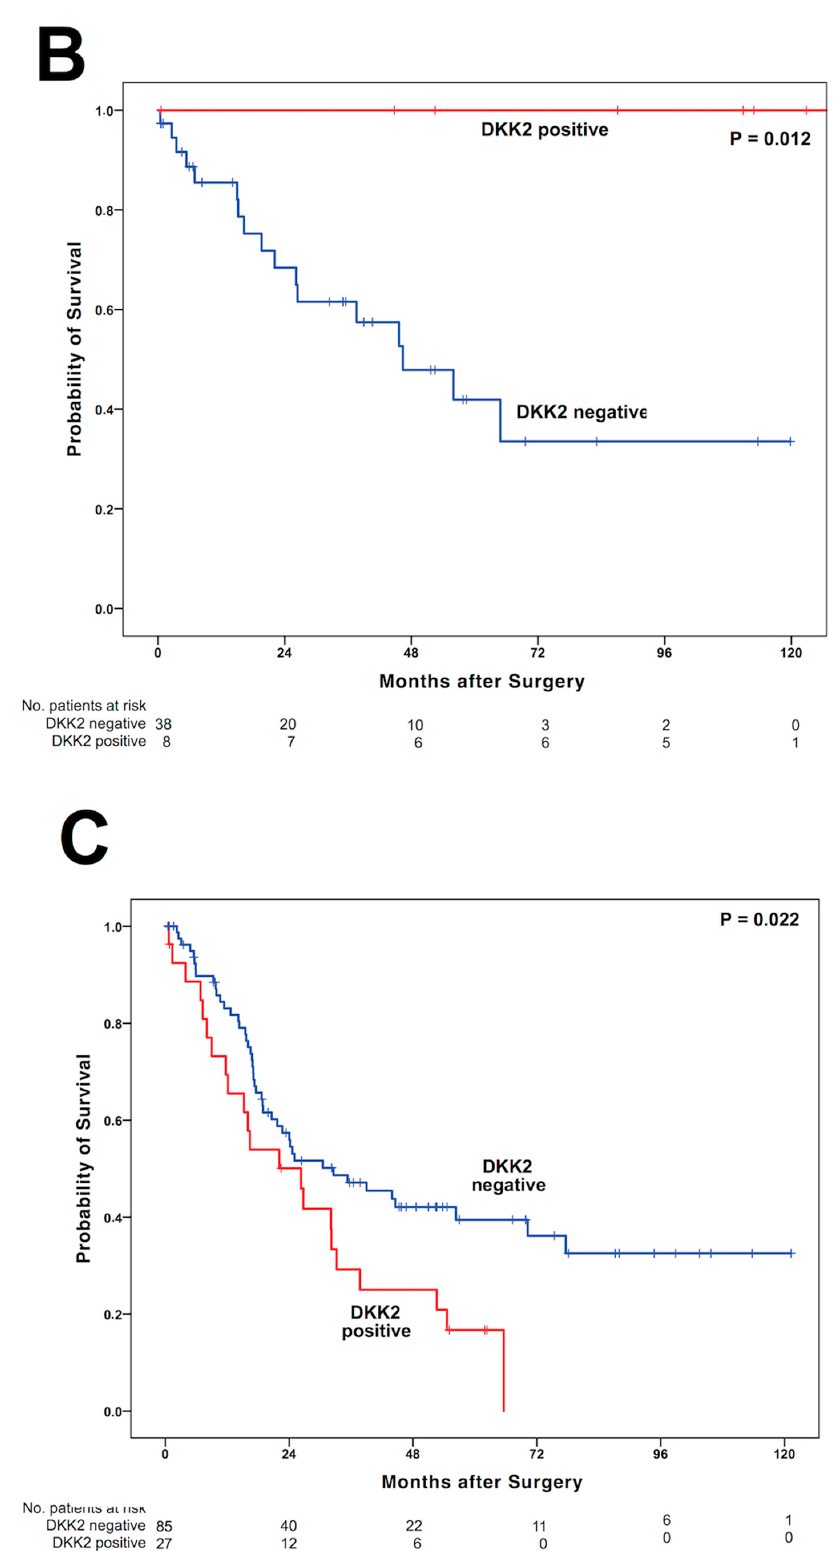
Figure 4. Kaplan–Meier survival analysis and survival plots for DKK2 expression and the entire cohort ( A ), patients after primary surgery without neoadjuvant treatment ( B ), and patients after neoadjuvant treatment ( C ).